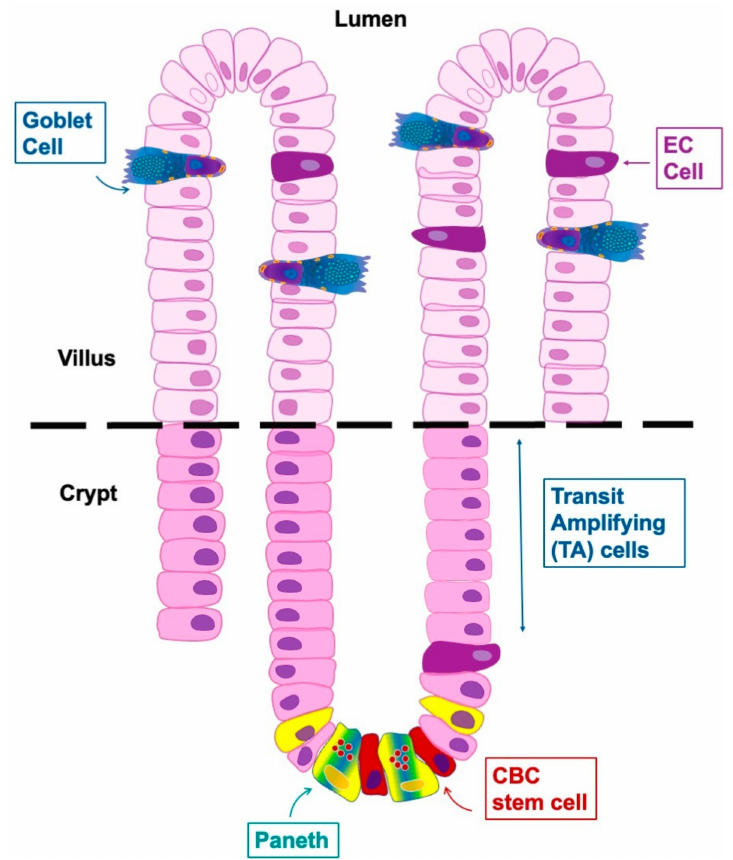
Figure 1. Schematic representation of the differentiation and functional anatomy of the crypt-villus unit. EC: enterochromaffin cell; CBC: rapidly cycling crypt base columnar cells; TA: proliferative transit-amplifying zone. Modified from Li et al., 2011